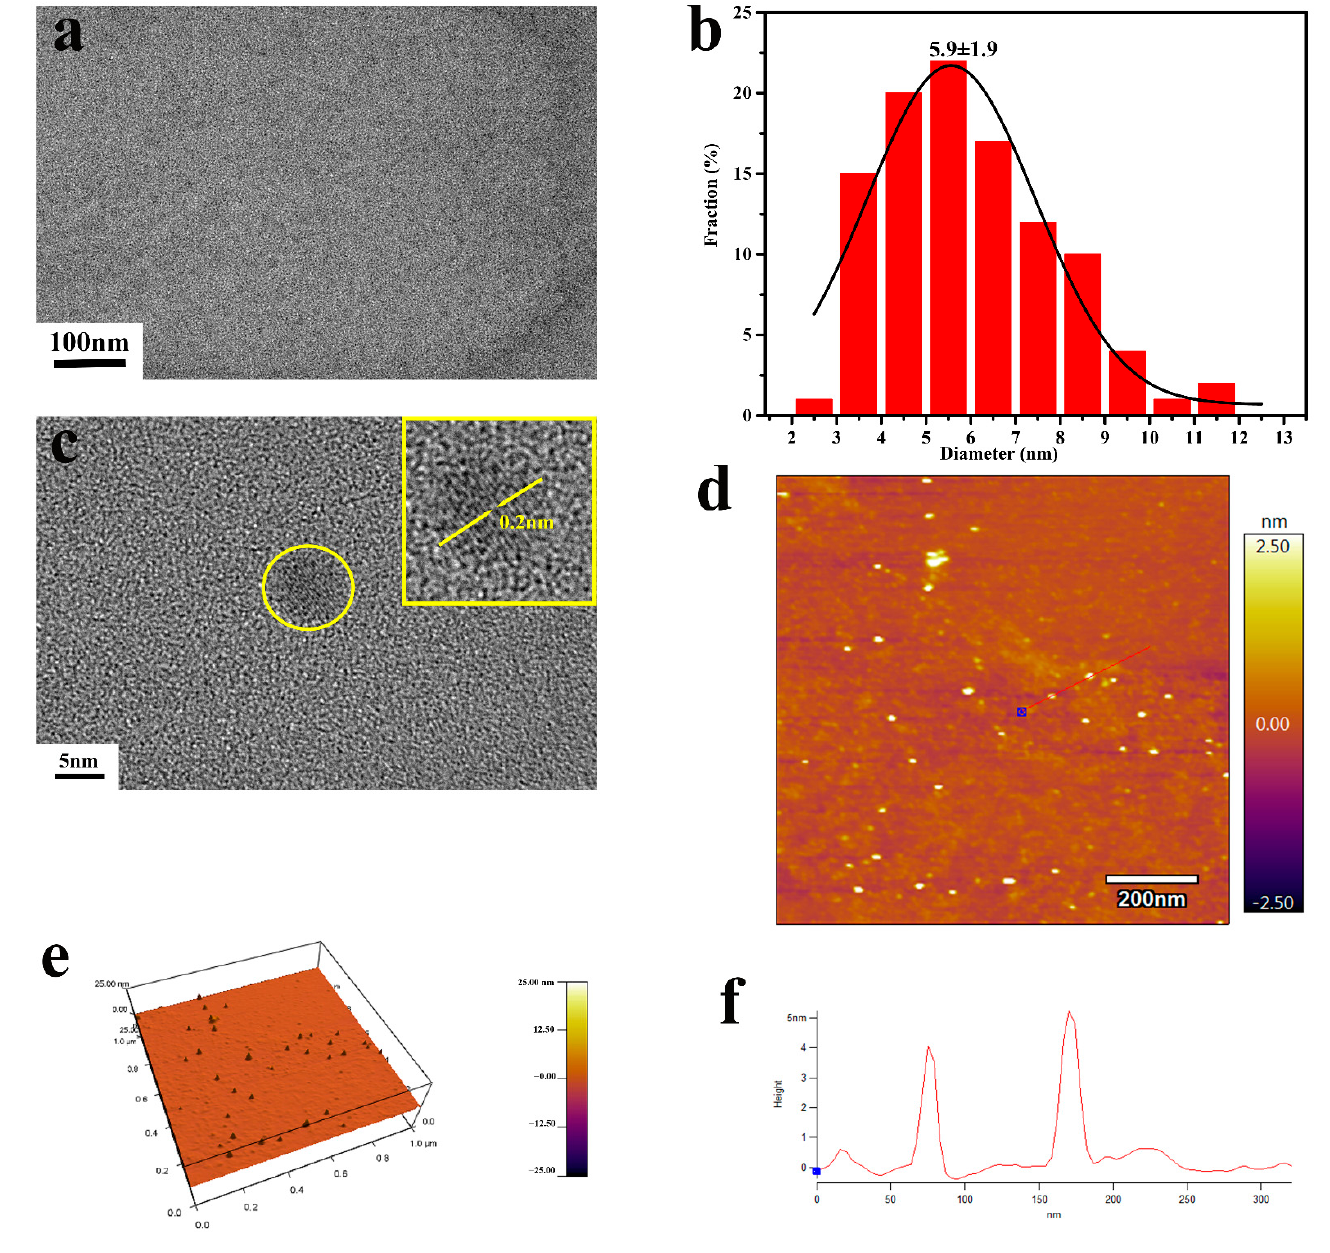
Figure 2. TEM image of CD C-H ( a ); particle size distribution histogram of TEM image of CD C-H ( b ); HRTEM image of a single CD C-H particle ( c ). Inset: enlarged image of one particle from ( a ); AFM topography image of CD C-H ( d ); AFM 3D image ( e ); height profile along the line in AFM topography image ( f ).